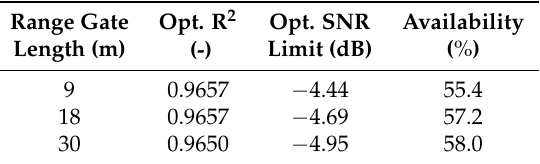
Table 3. Optimal R 2 values and the corresponding Signal-to-noise ratio (SNR) limit and availability for the different range gate